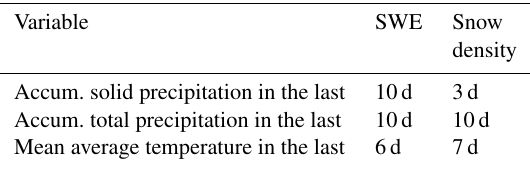
Table 1. Variables having the largest absolute Spearman correlation between the target variable and the last three explanatory variables for n ranging between 1 and